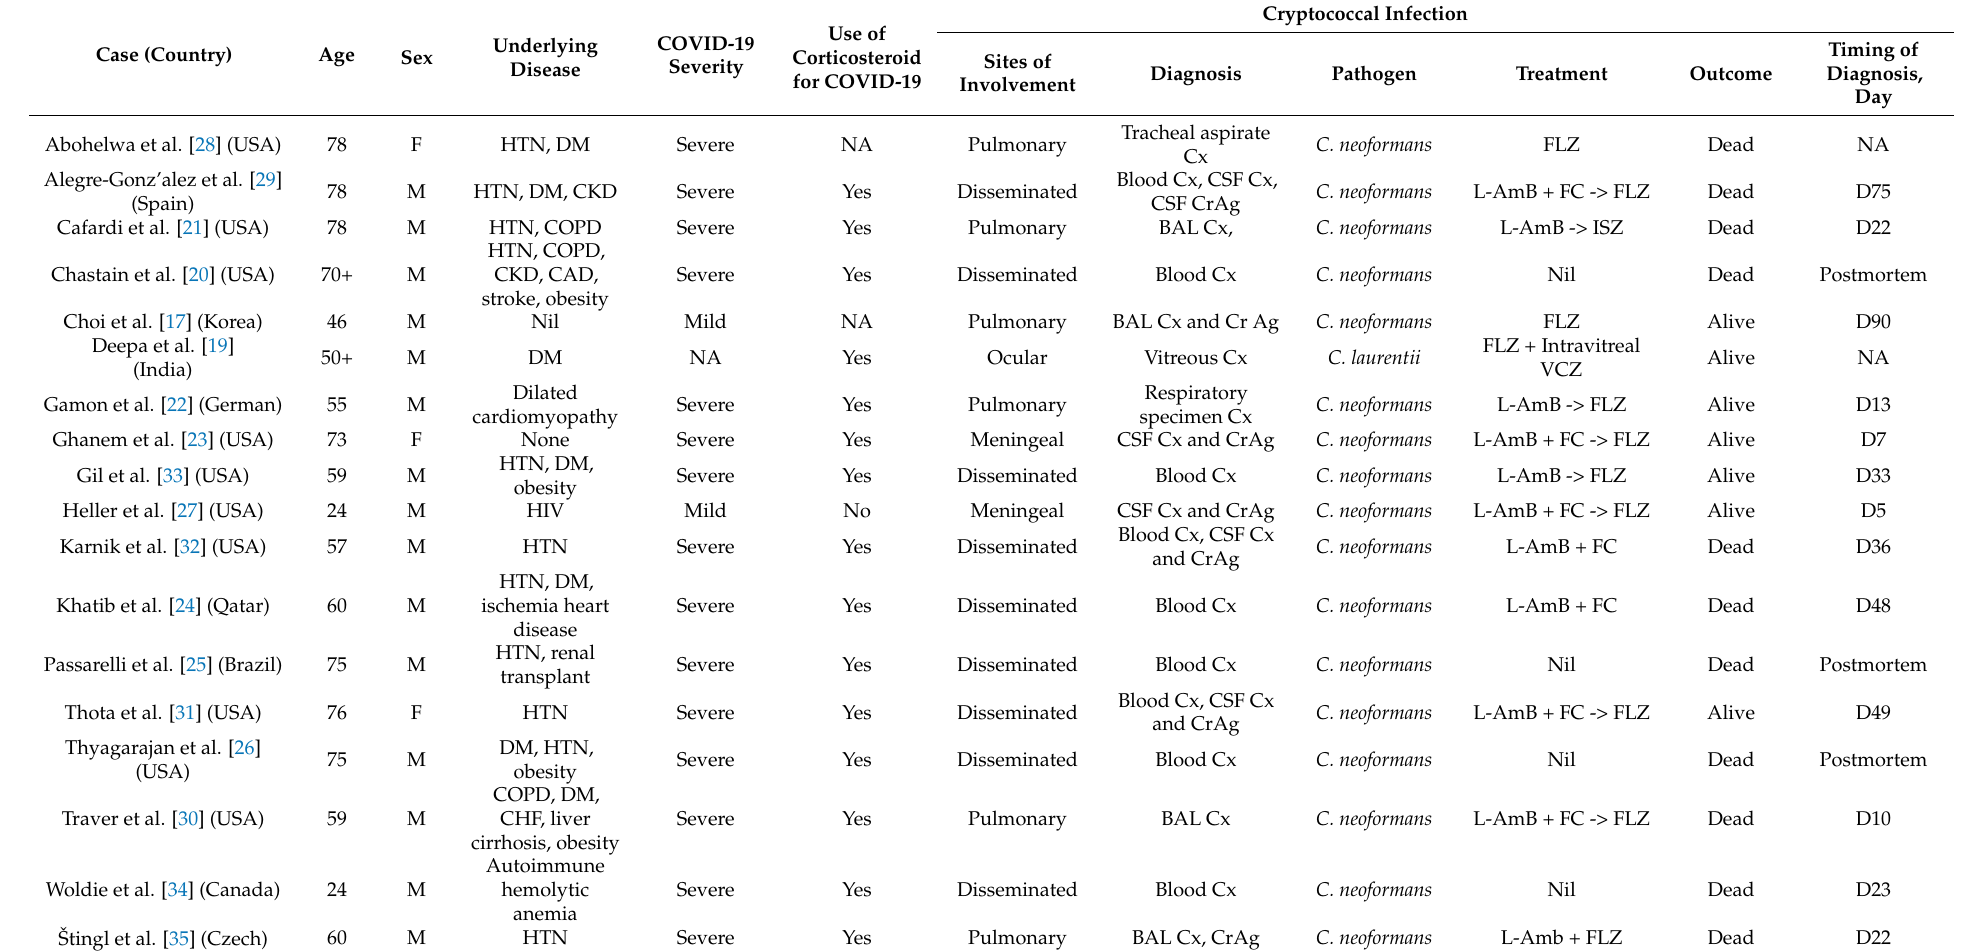
Table 1. Clinical characteristics of the 18 reported cases with COVID-19-associated